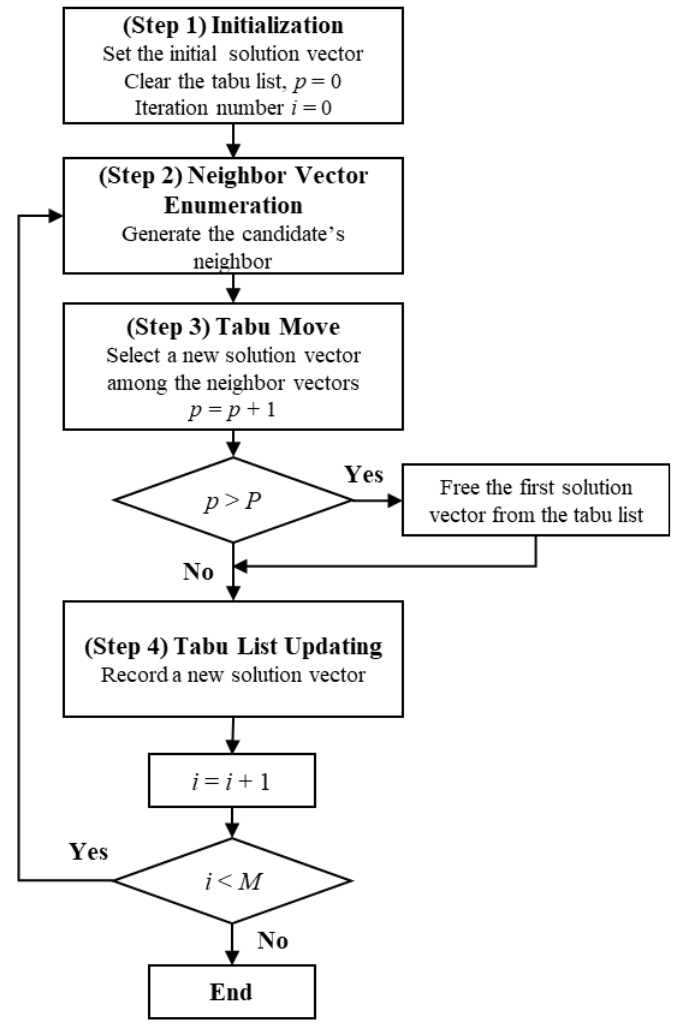
Figure 2. Flow chart of the TS algorithm.